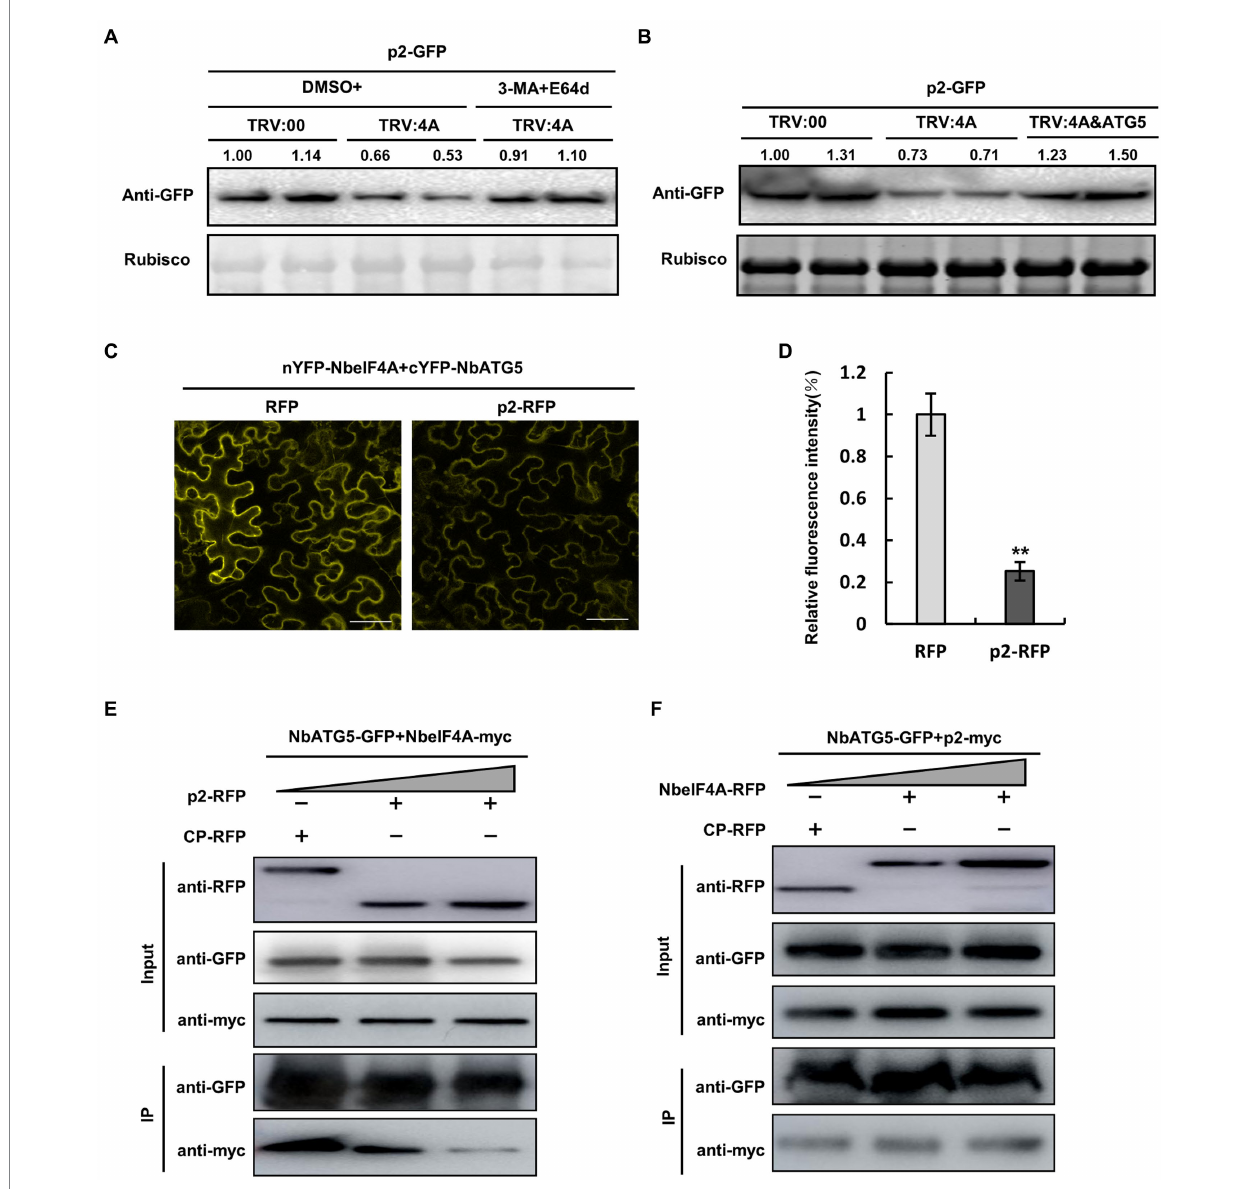
FIGURE 5 NbATG5 has greater affinity to p2 than to NbeIF4A. (A,B) Accumulation of GFP-fused p2 was reduced in NbeIF4A -silenced (TRV:4A-infected) plants, compared to that in the control (TRV:00-infected). Meanwhile, the reduction was inhibited by 3-MA or E-64d treatment (A) or by co-silencing of ATG5 (B) . (C,D) BiFC assay showing the interaction between NbeIF4A and NbATG5 with obvious yellow fluorescence in the presence of RFP (C) . When p2- RFP was co-expressed, the intensity of yellow fluorescence was significantly reduced (D) , indicating that p2 interferes with the interaction between NbeIF4A and NbATG5. Bars, 50 μ m. Samples were observed by laser confocal microscopy at 60 hpi. The asterisks indicate significant difference by Student’s t test (** p < 0.01). (E,F) Co-IP assay of NbeIF4A-myc and NbATG5-GFP in the presence of p2; the amount of NbeIF4A immunoprecipitated by